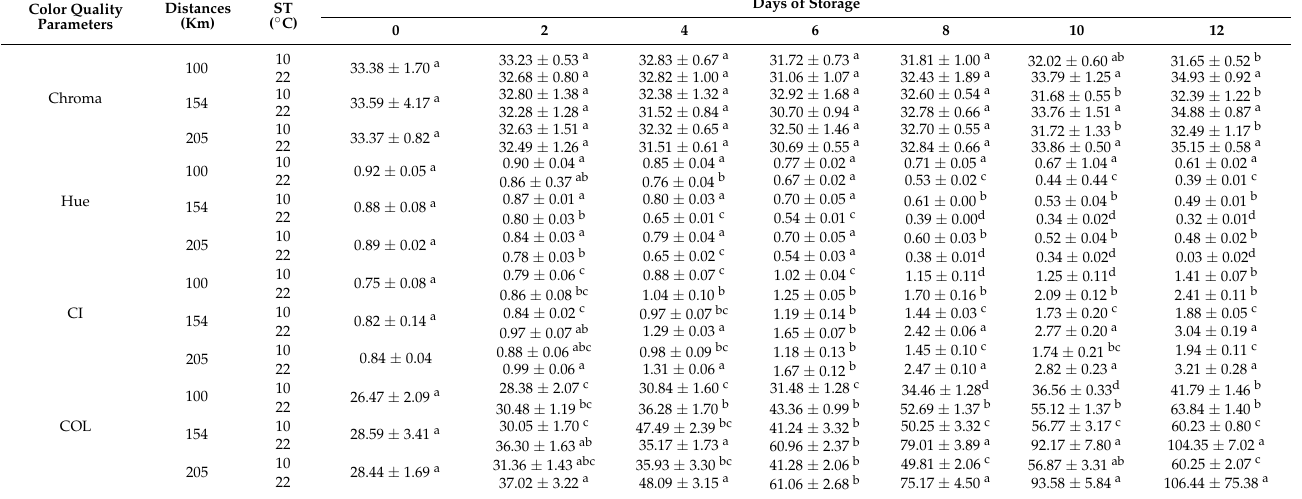
ST, storage temperature; CI, color index; COL, tomato color